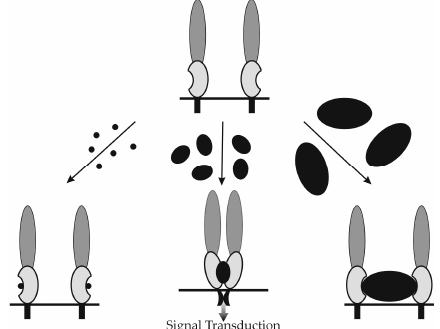
Figure 8. A model for HA-size dependent activation of HARE and ERK signaling. The scheme [80] leads to HARE dimer formation and activation of signal transduction (bottom middle). Symbols denote; membrane (horizontal black lines), CD (black rectangles), HA binding Link module (light gray indented ovals), ectodomain (N-terminal to Link module; long dark gray ovals) and HA size ranges of < 40 kDa (small black dots), 40–400 kDa (small black ovals) and > 400 kDa (large black ovals).